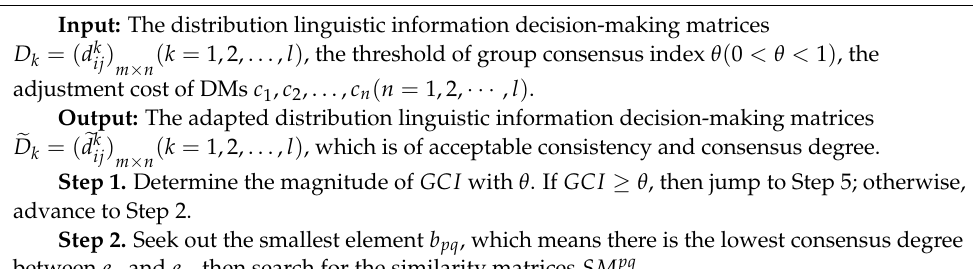
Algorithm 2. Consensus-adjustment process for